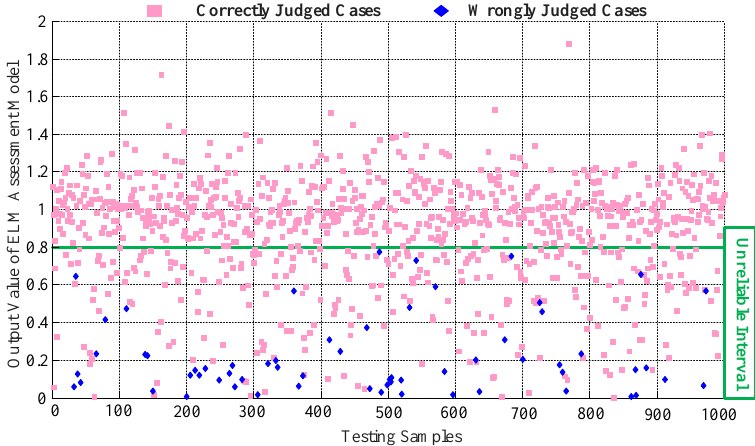
Figure 7. ELM-based stability assessment model output distribution with testing samples.